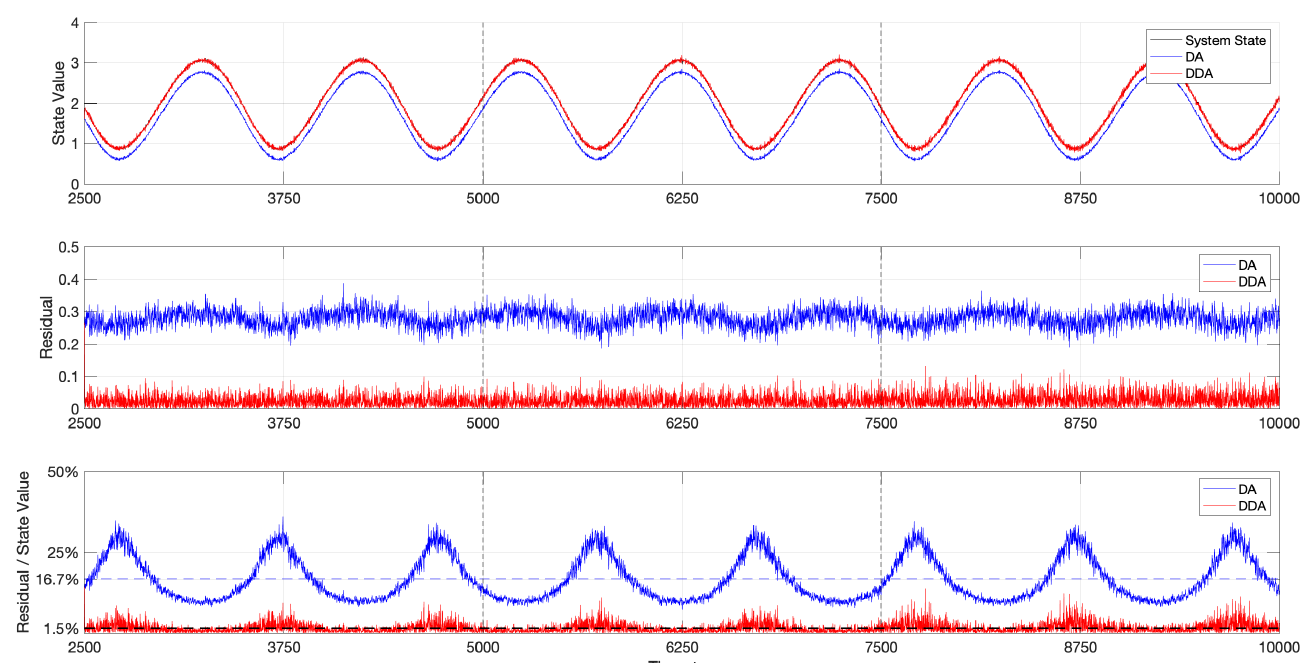
Figure 10. Simulation result of DDA on double integral system considering the model error. The vertical dash-lines refer to the training